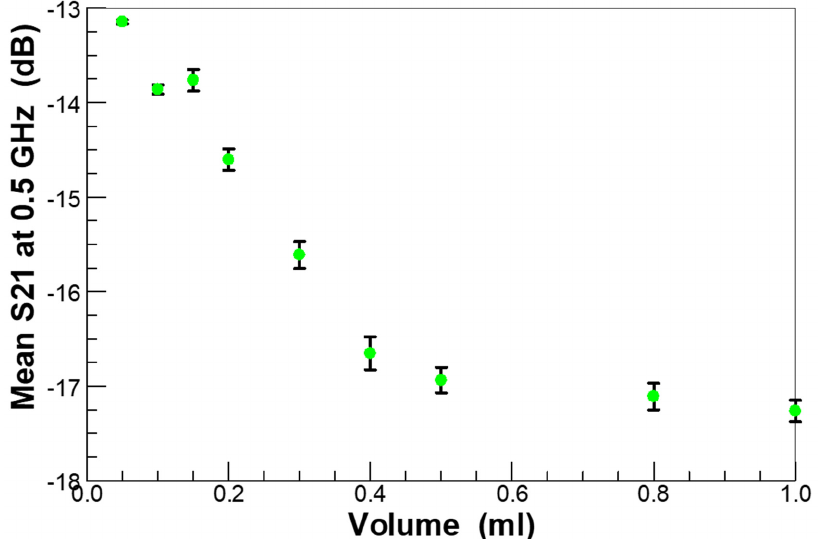
Figure 4. Methanol concentration dependence of the time-averaged microwave insertion loss amplitude (S 21 ) TCNQ-loaded HKUST-1 SURMOF on Si substrate at 65 °C, purged with pure air, monitored at 0.5 GHz. The error bars represent the standard deviation of at least three five-minute measurements for each aliquot of methanol.